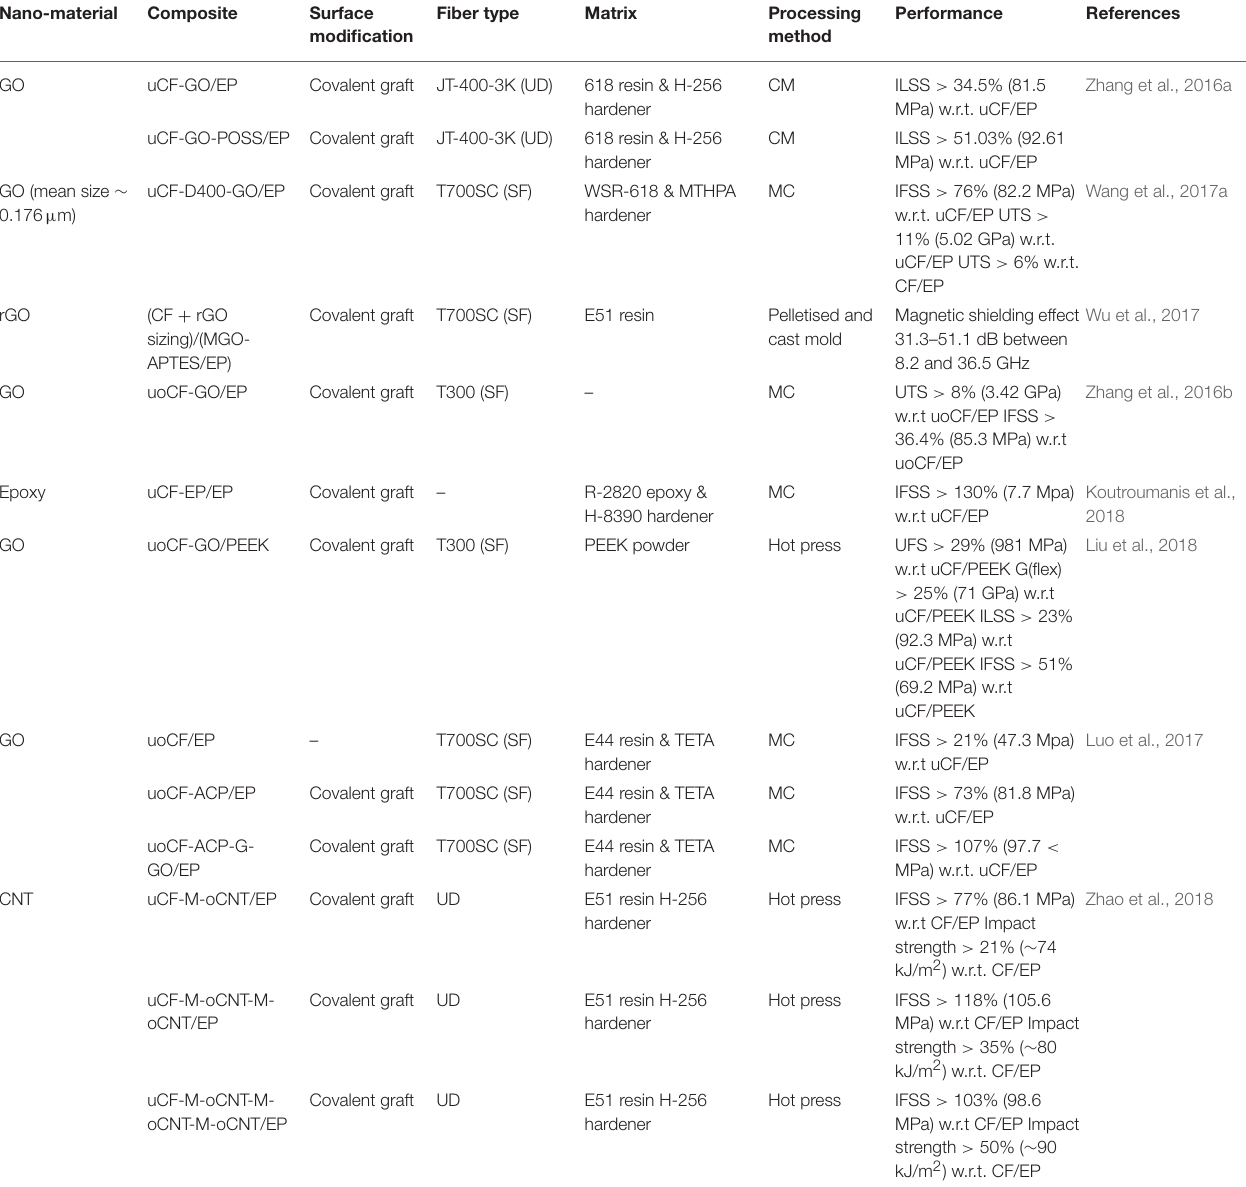
TABLE 1 | A summary of results from literature investigating covalent graft methods to modify the fiber surface properties.